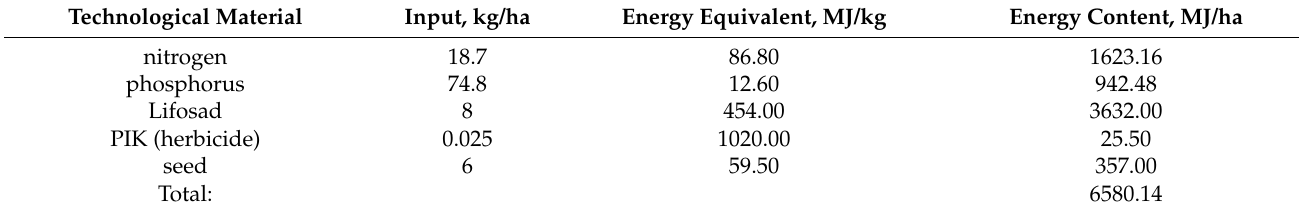
Table 8. Indirect energy